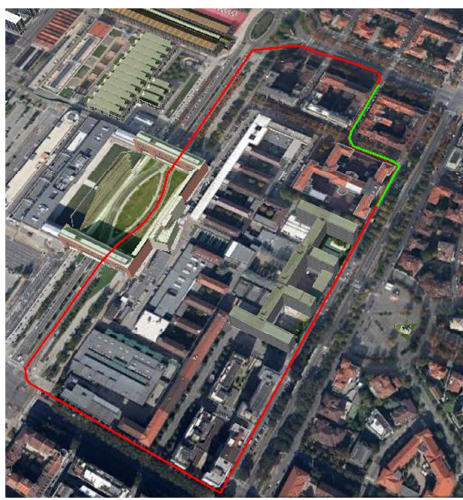
Figure 1. In red: vehicle’s trajectory, in green: portion of trajectory